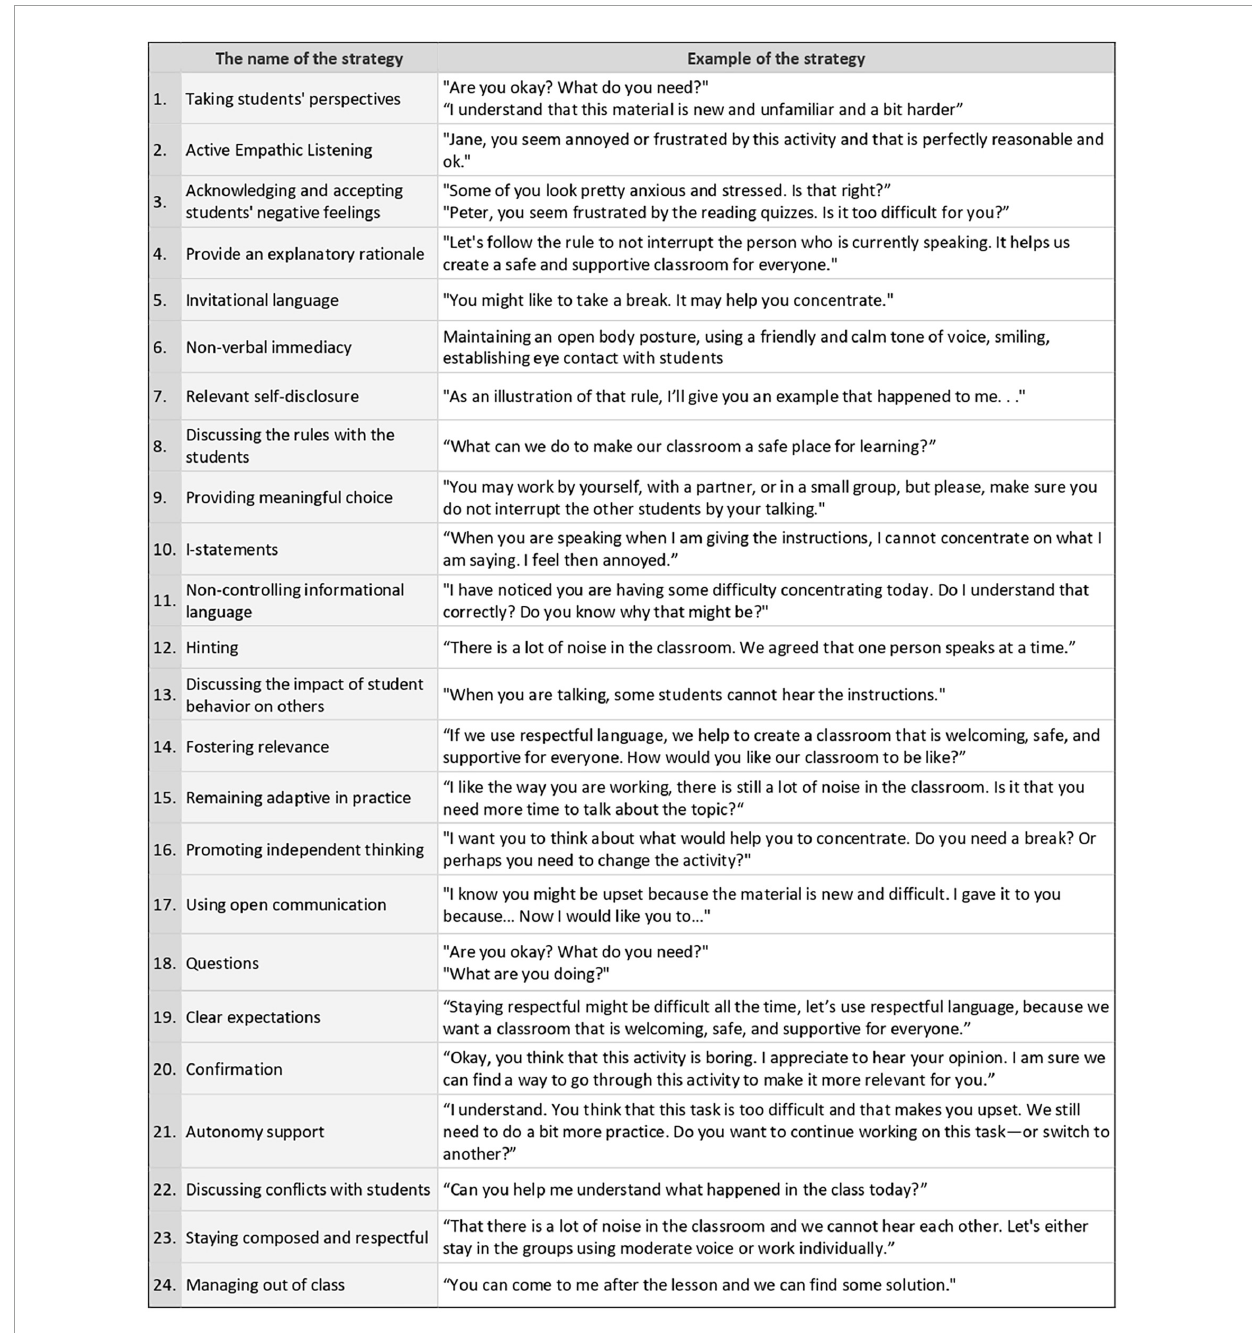
FIGURE3 Strategies identified throughout the